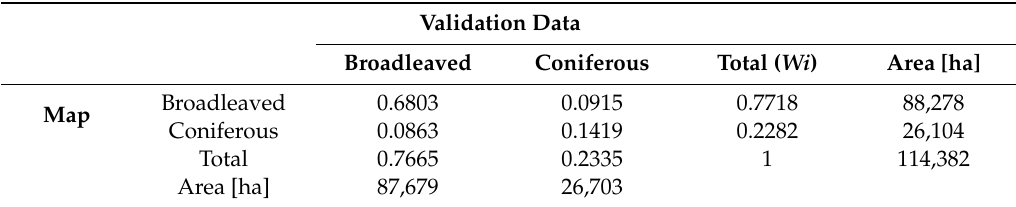
Table 8. Error matrix of estimated proportions of area (bootstrap based prediction map using Sentinel-2 derived NDVI in the Saarland).